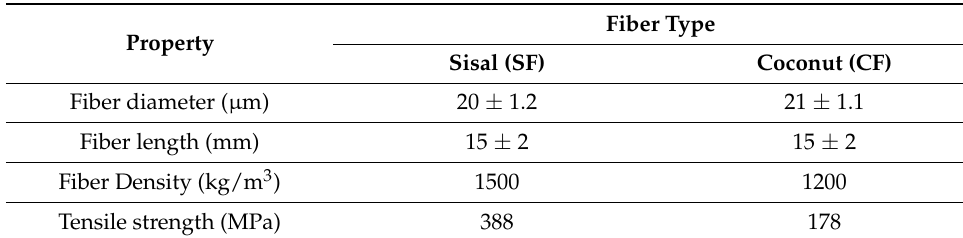
Table 8. Characteristics of dispersed reinforcing fibers.